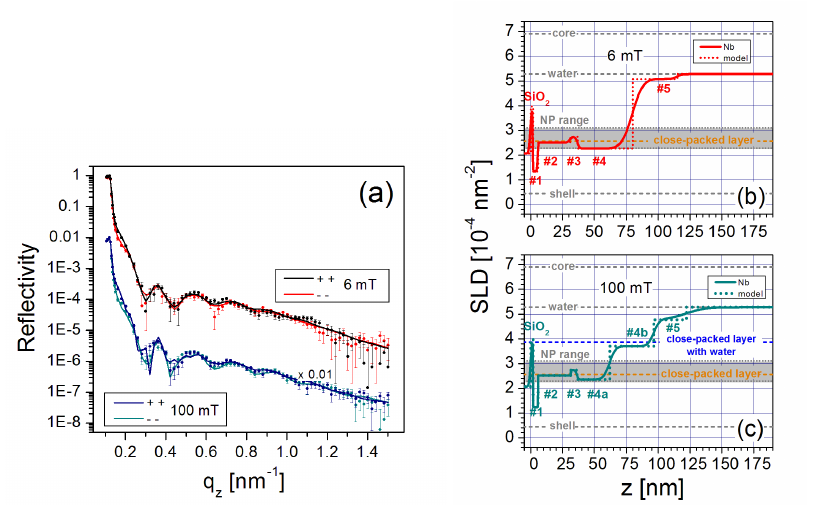
Figure 8. ( a ) PNR data and fits for a FF with monodispersed, spherical NPs on APTES taken in magnetic fields of 6 mT and 100 mT. The data and fits for the 100 mT measurements were scaled by 0.01 for clarity. ( b , c ) Profiles of the nuclear SLDs as a function of distance z from the Si surface obtained from the model fits to the 6 mT and 100 mT PNR data, respectively [50].